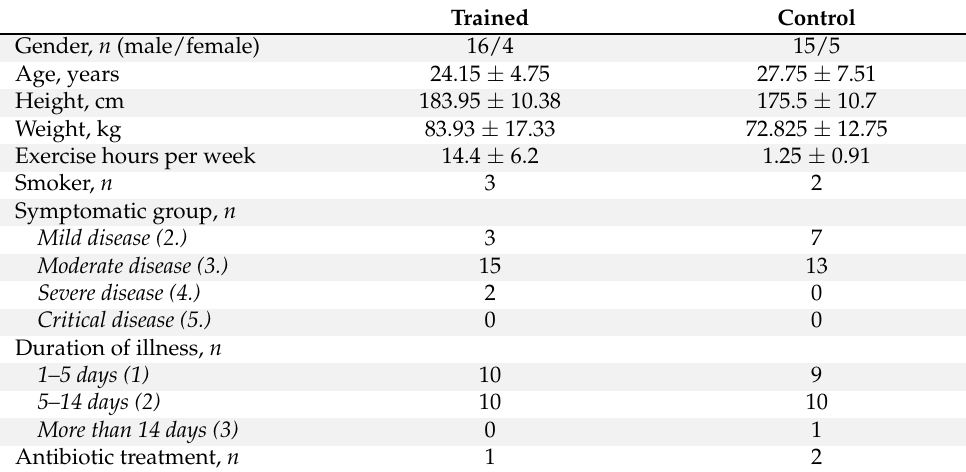
Table 1. Characteristics of the trained and control